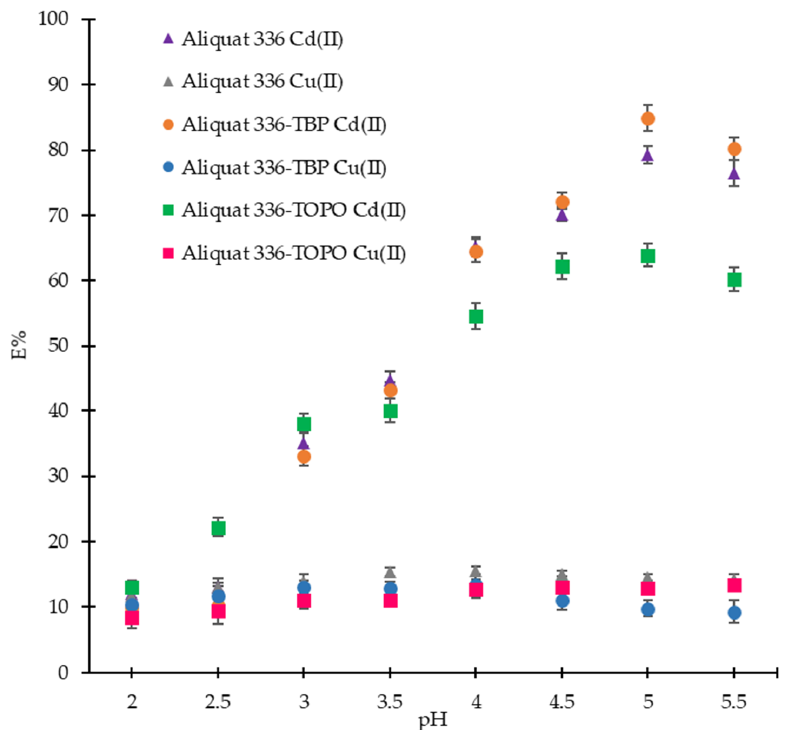
Figure 1. Effect of pH on the extraction of Cd(II) and Cu(II) ions using Aliquat 336 and combinations of Aliquat 336 with TBP and TOPO (mixing time: 10 min; operating temperature: 28 ± 1 °C; mixing speed: 150 rpm; Na 2 SO 4 : 200 mM; diluent: toluene; M i : 100 mg/L; O:A ratio = 1:1; Aliquat 336: 100 mM; TBP: 50 mM; TOPO: 50 mM).